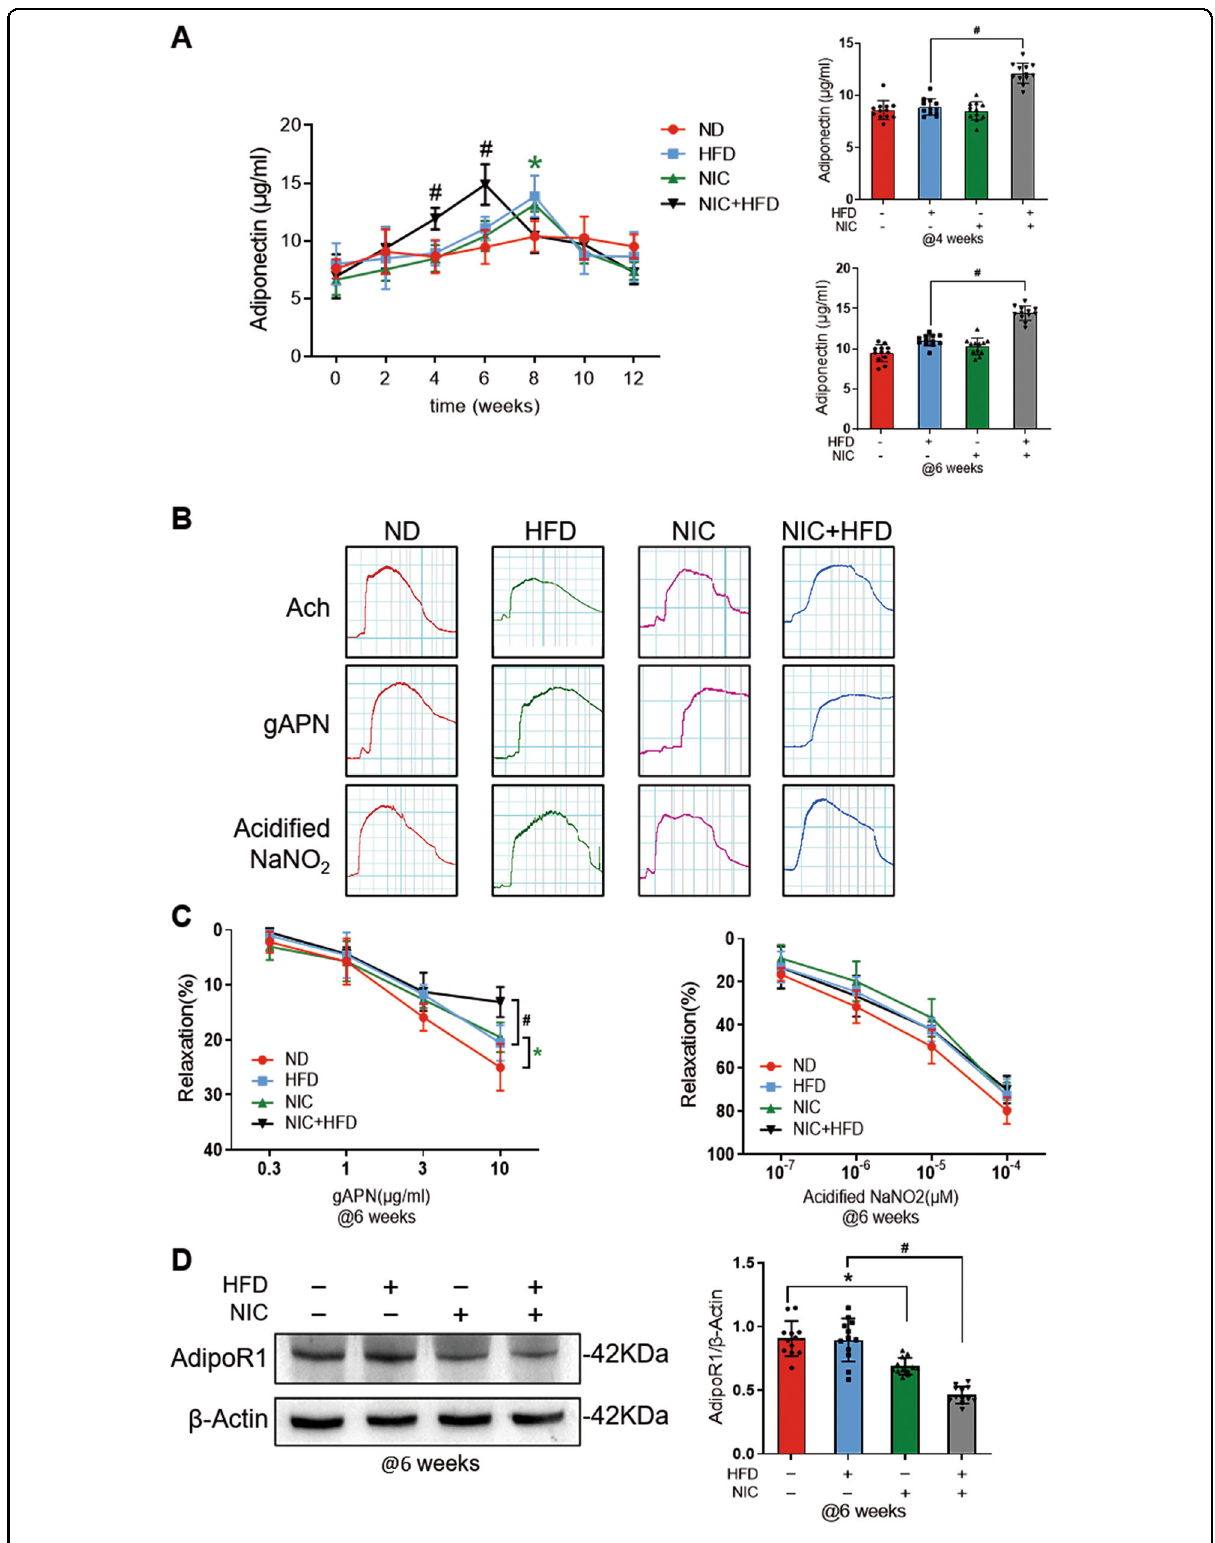
Fig. 1 (See legend on next